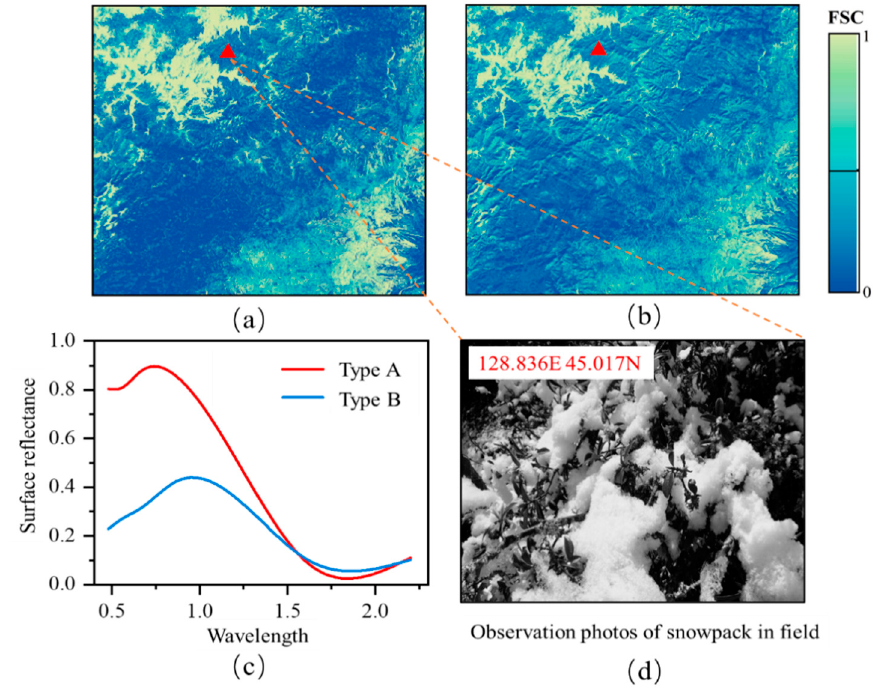
Figure 12. Validation of the effect of different numbers of snow endmembers on the accuracy of FSC retrieval. ( a ) and ( b ) are the SSEmod FSC that retrieved by a single snow endmember and two snow endmembers, respectively. ( c ) the different types of snow endmembers were extracted from the image. ( d ) snowpack photo was taken in the field.